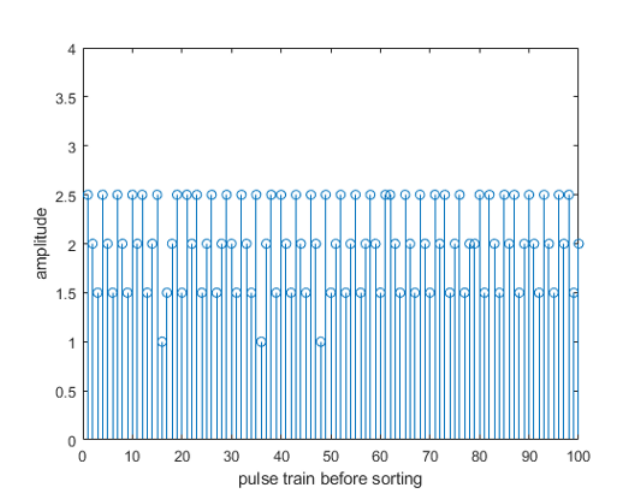
Fig. 5. Pulse sequence after sorting